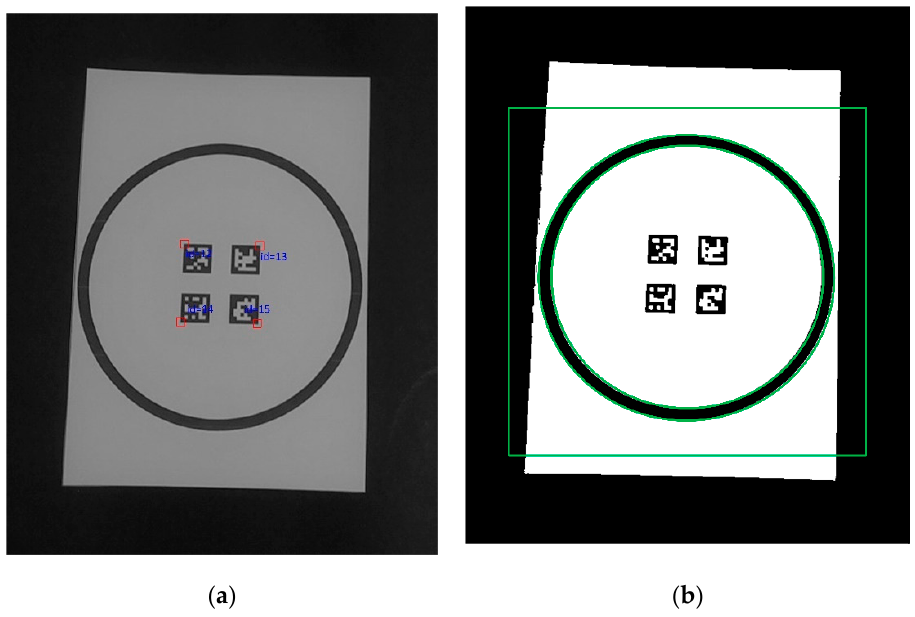
Figure 20. Descent control while long-range and short-range are available. ( a ) ArUco markers first detection; top left corners are detected, and the dictionary entries are identified; the rotation of the markers generates two diagonals whose intersection indicates landing destination. ( b ) At this flight level, the circle is still visible and allows confrontation of destination point coordinates between the two methods.